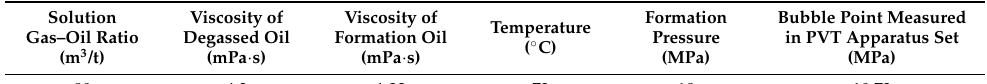
Table 4. Parameters of the experiments.